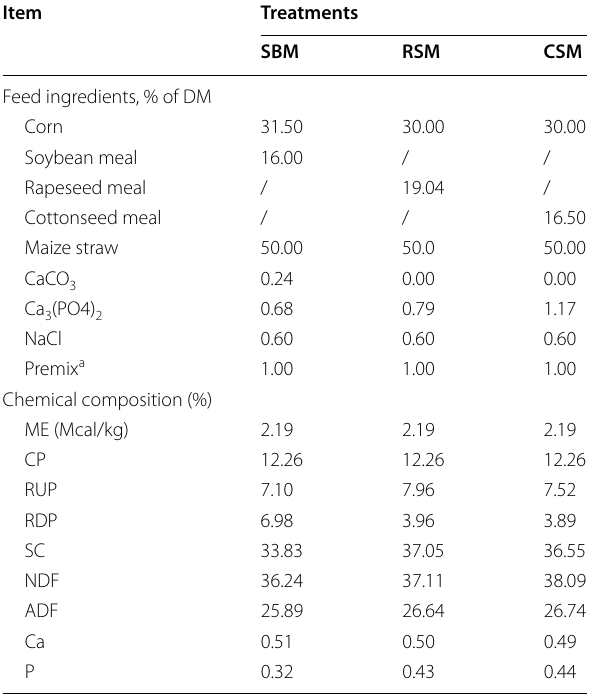
Table 1 Composition and nutrient levels of basal diets (DM